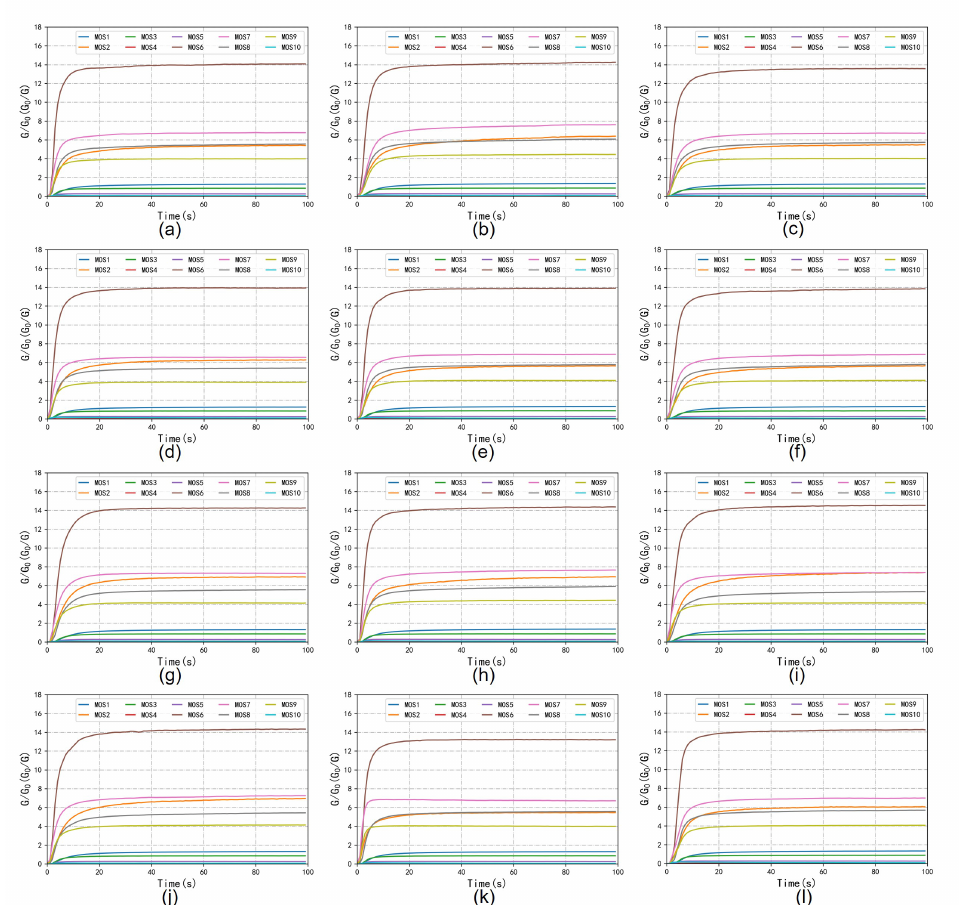
Figure 5. Examples of the 10 sensors’ response curves. ( a ) HSMF; ( b ) YDMF; ( c ) EMMF; ( d ) LXMF; ( e ) QSMF; ( f ) MTMF; ( g ) XYMJ; ( h ) GLMJ; ( i ) DYMJ; ( j ) GZMJ; ( k ) QSMJ; ( l )